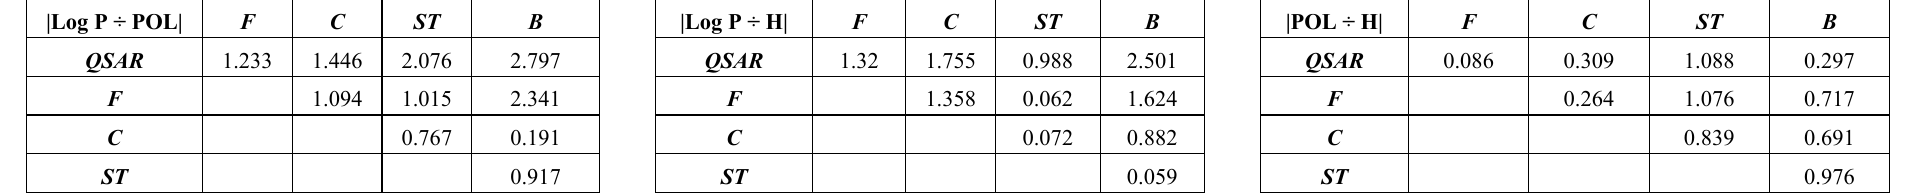
Table 8. Differences between the single-structure matrices of the Euclidean distances in Table 7.